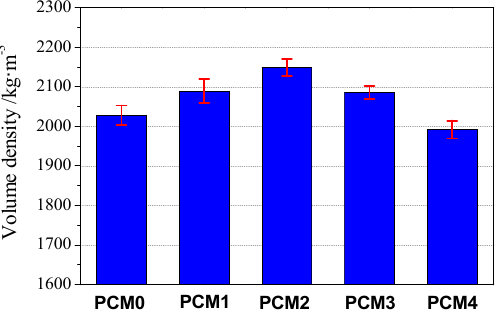
ff ects of PVA content on the volume density of cement Figure 7. Effects of PVA content on the volume density of cement mortar. Figure 7. E